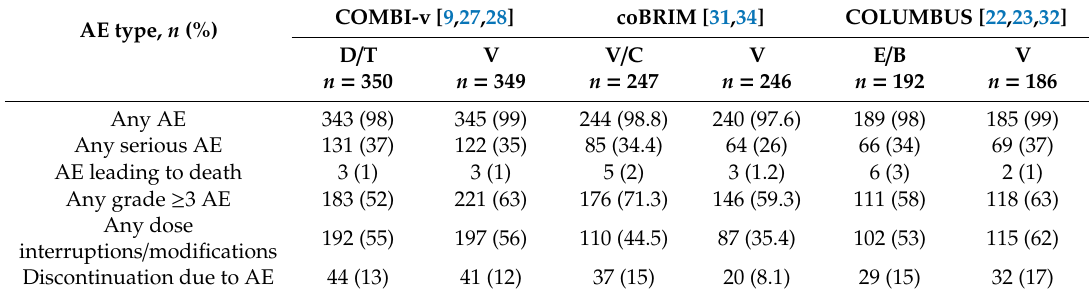
Table 3. Overall summary of safety for the COMBI-v, coBRIM, and COLUMBUS